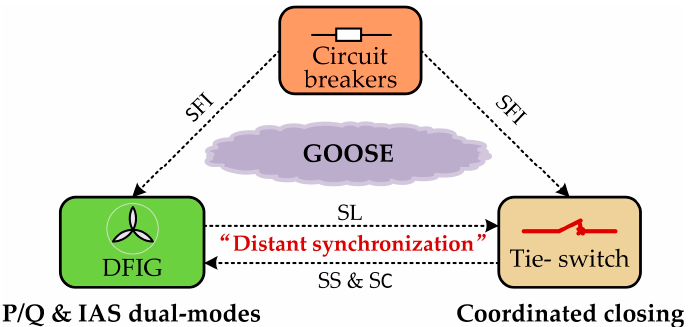
Figure 5. Framework of the coordination control strategy.